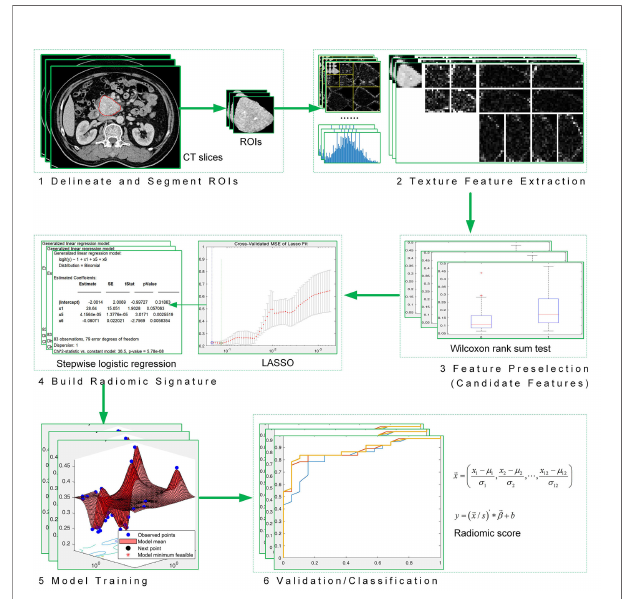
FIGURE 1 | Work fl ow of radiomic